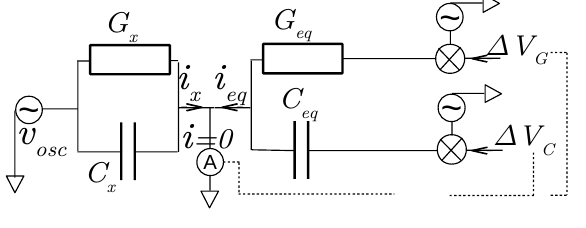
eq ∆ V under the voltage v (using a eq osc G ω under the voltage v ∆ V offsets the eq osc C